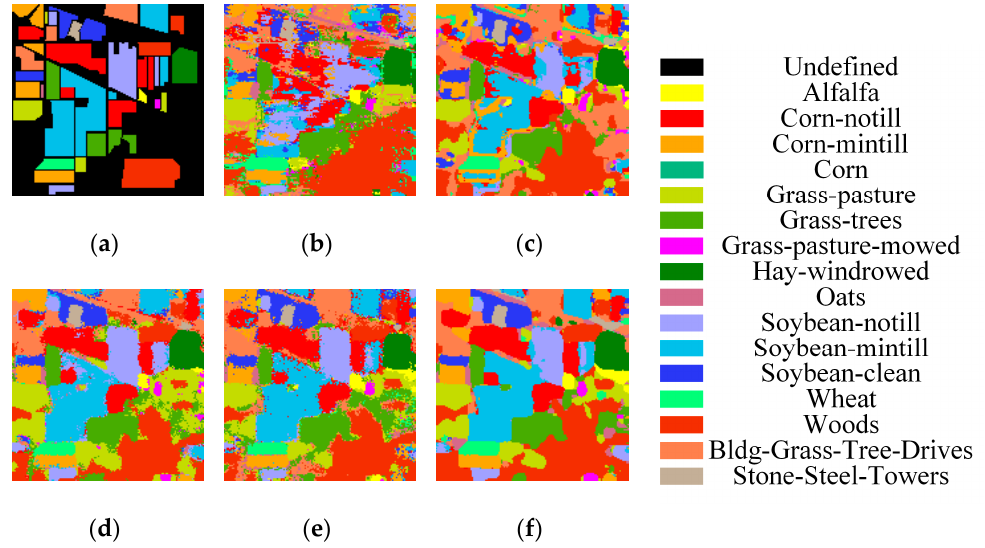
Figure 8. Classification maps for Indiana Pines dataset: ( a ) Ground-truth map, ( b ) SSLSTMs, OA = 67.30%, ( c ) 3D CNN, OA = 79.22%, ( d ) FDSSC, OA = 92.77%, ( e ) SSRN, OA = 95.21%, ( f ) SSCC, OA = 97.70%.